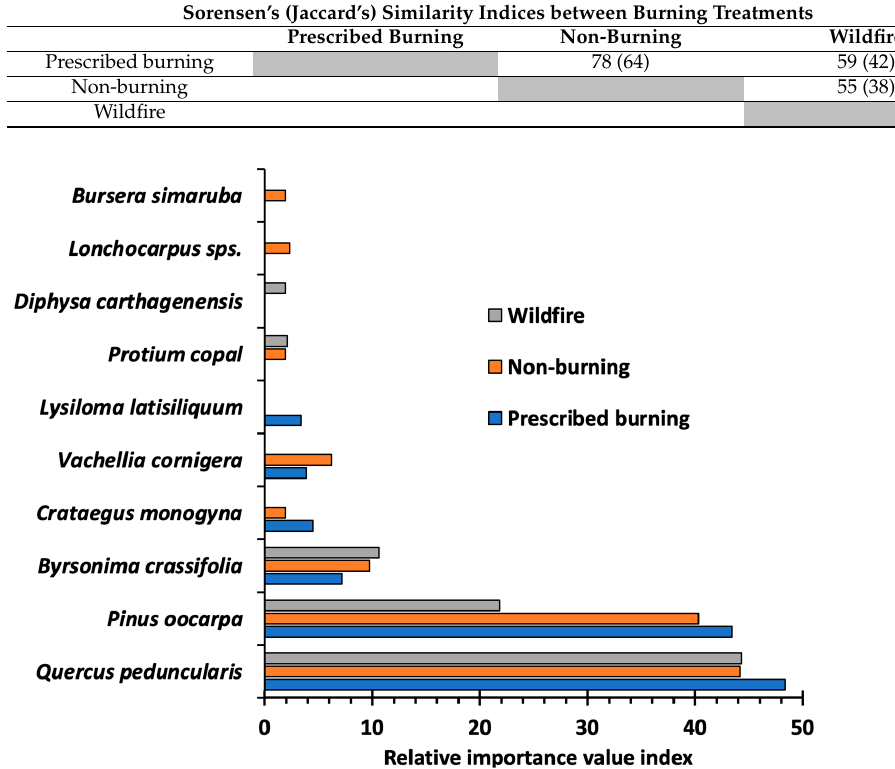
Figure 3. Relative importance value indices of tree species among three different fire types: prescribed burning, non-burning, and wildfire.